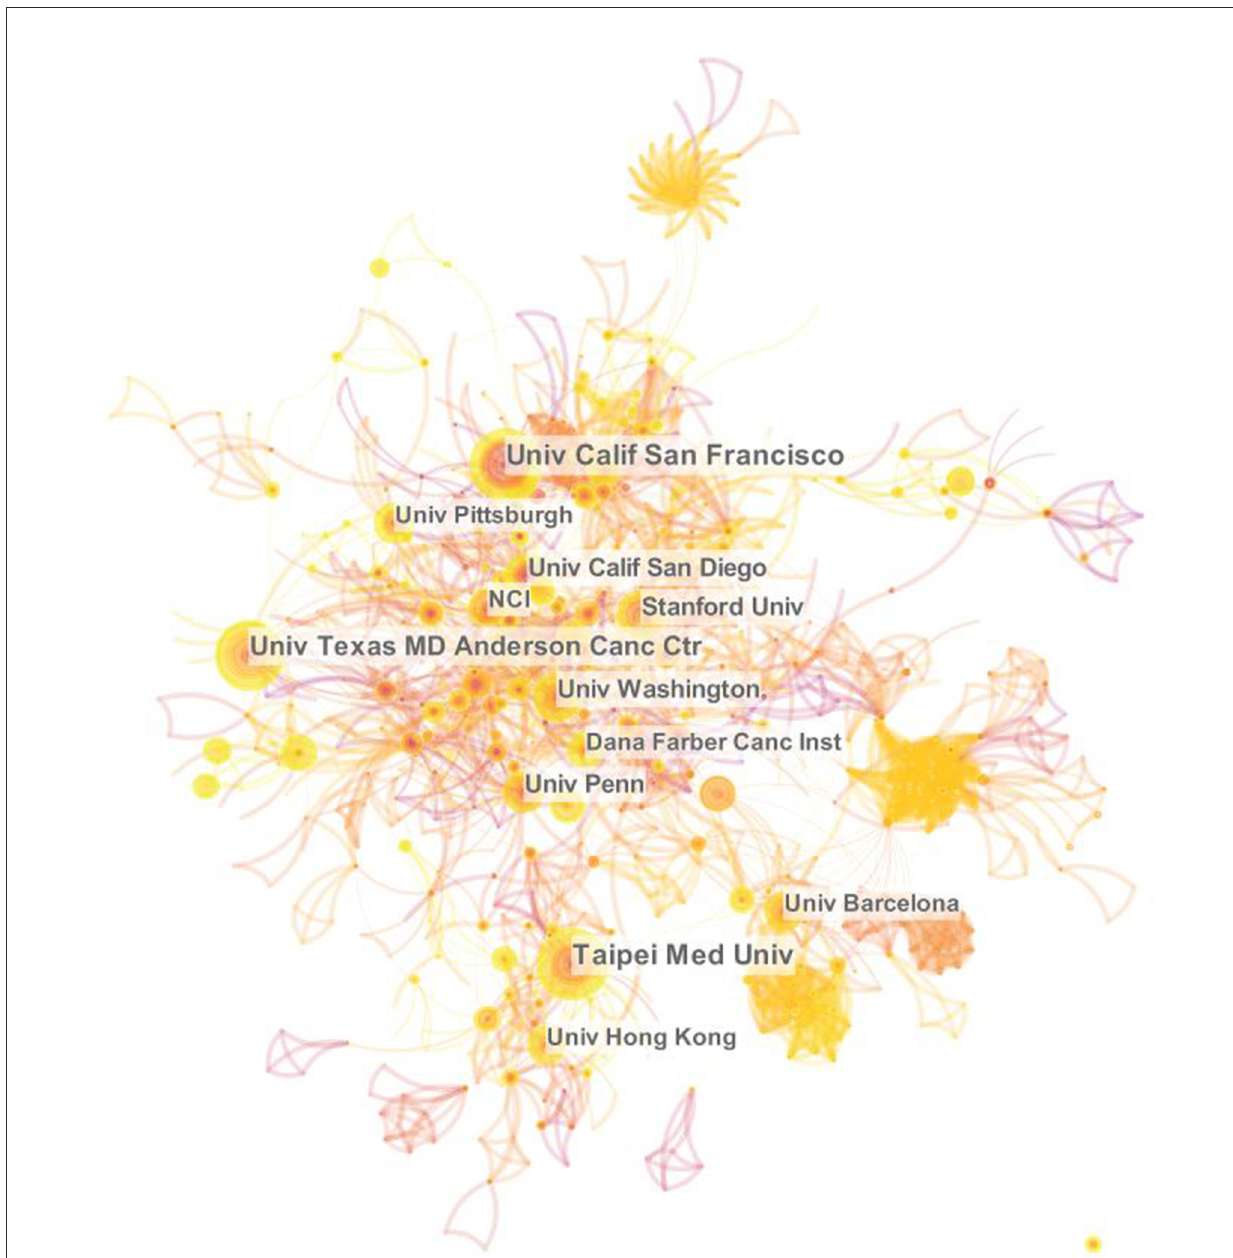
FIGURE3 Collaboration network of institutions on cancer and sleep research from 2002 to 2022.